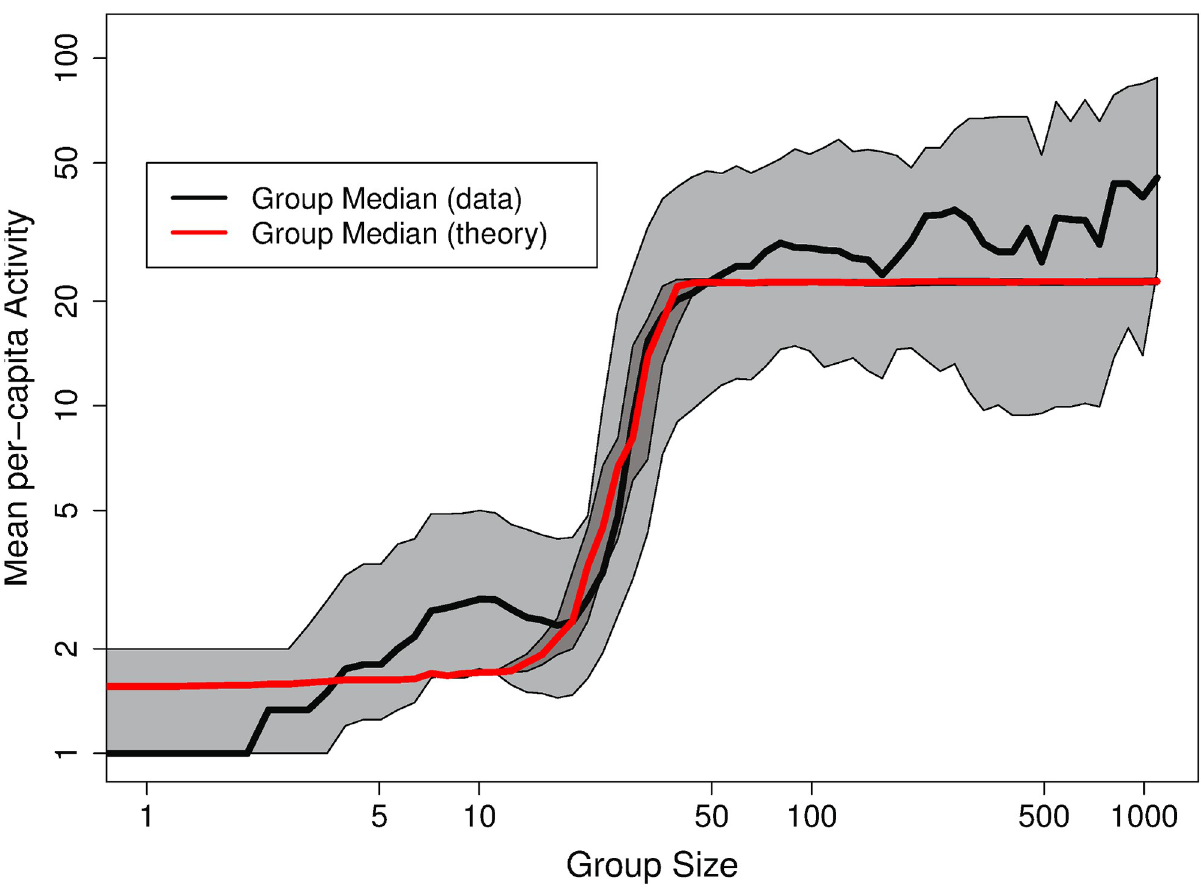
Fig 6. Fit of MLE estimations. The model fit is shown in red and the respective percentile envelope overlay the data, as in 1.